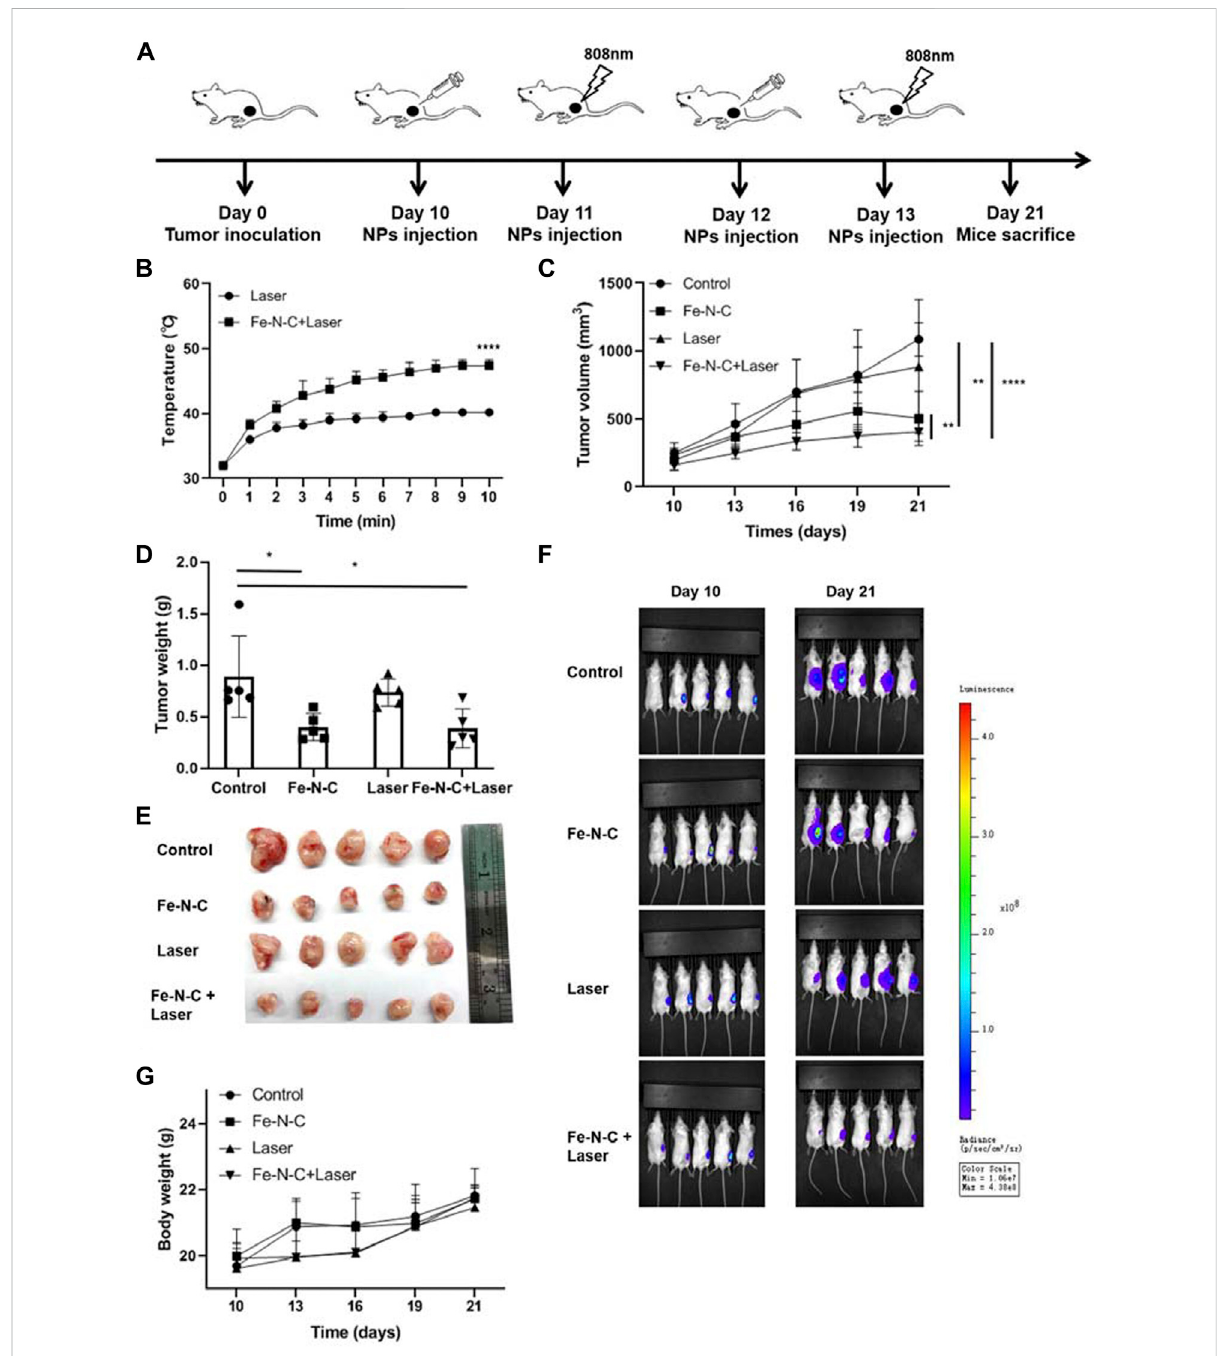
FIGURE 8 CDT/PTTeffectofFe-N-CSAzymes invivo . (A) SchematicdiagramofourexperimentstostudytheantitumoreffectofFe-N-CSAzymes invivo . Subcutaneous tumor was established by luciferase-labeled 4T1 cells. Fe-N-C treatment was performed by intratumoral injection. (B) The temperature changes of tumor surface were recorded during 808 nm laser exposure (1.0 W cm − 2 ) for 10 min, 24 h after Fe-N-C (200 μ g) intratumoral injection. (C) Tumor volumes were determined and the tumor growth curves were plotted for indicated treatments (mean ± S.E.M.). (D) and (E) Tumorweightofsacri fi cedmiceatday21(mean±S.E.M.). (F) Invivo fl uorescenceimagesoftumor-bearinglivingmicebeforeand after treatment. (G) Body weight changes were recorded during treatments. In vivo data are representative of two independent experiments. Summary data are shown as the mean ± S.E.M. with p values determined by two-tailed Student ’ s t -test (* p < 0.05, ** p < 0.01, *** p < 0.001, **** p <